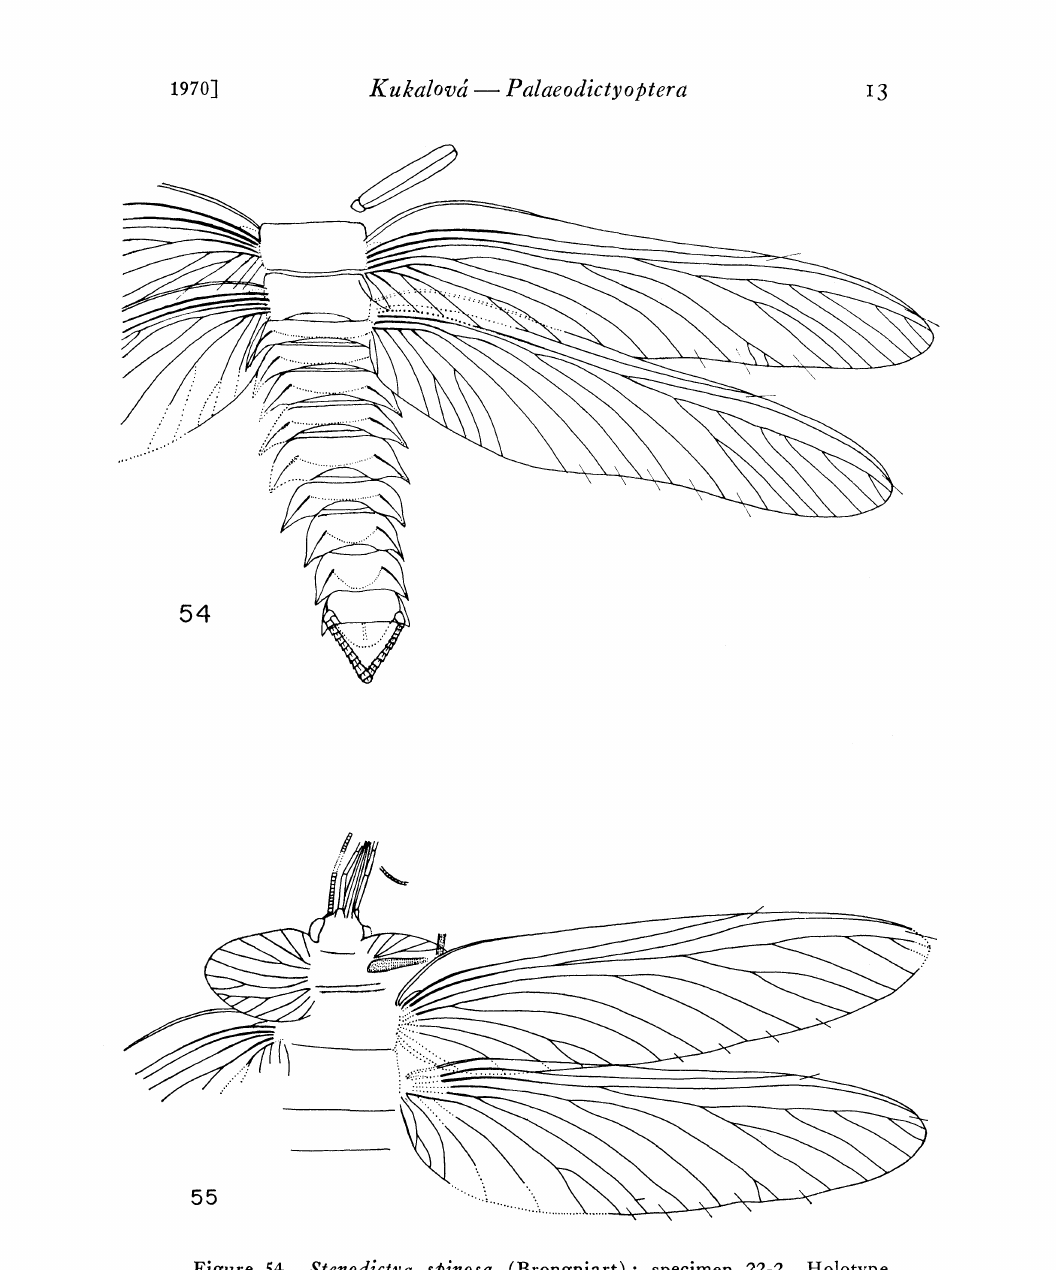
Figure 54. Stenodictya spinosa (Brongniart); specimen 22-2. Holotype. Figure 55. Stenodictya laurentiauxi sp. nov.